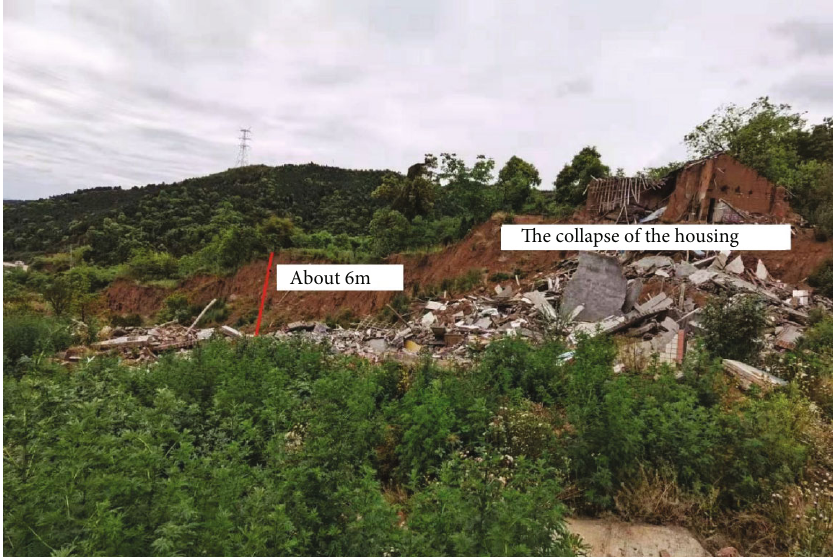
Figure 8: Fault zone at the back edge of the landslide. The trailing edge of the collapse zone extends from north to southwest, with a maximum depth of 6 m and a total length of approximately 210